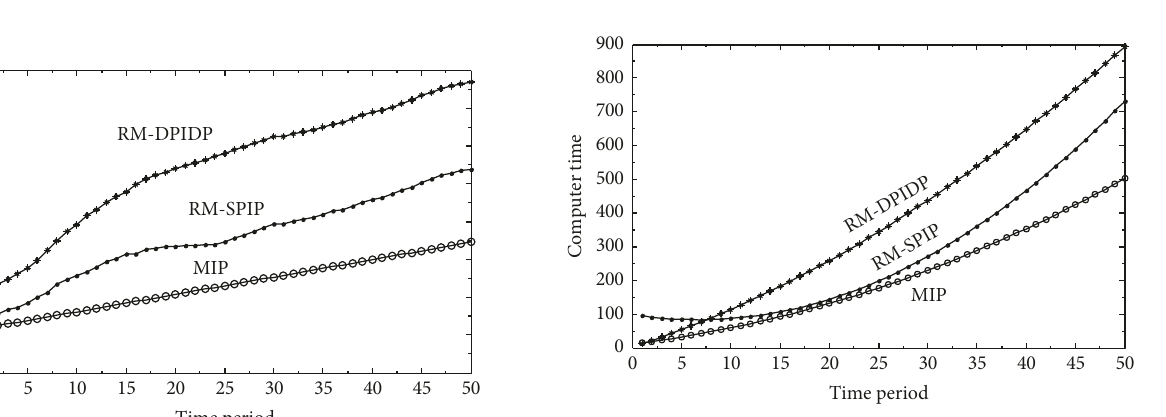
Figure 5: The OPT performance of 3 models for different length of planning horizon.